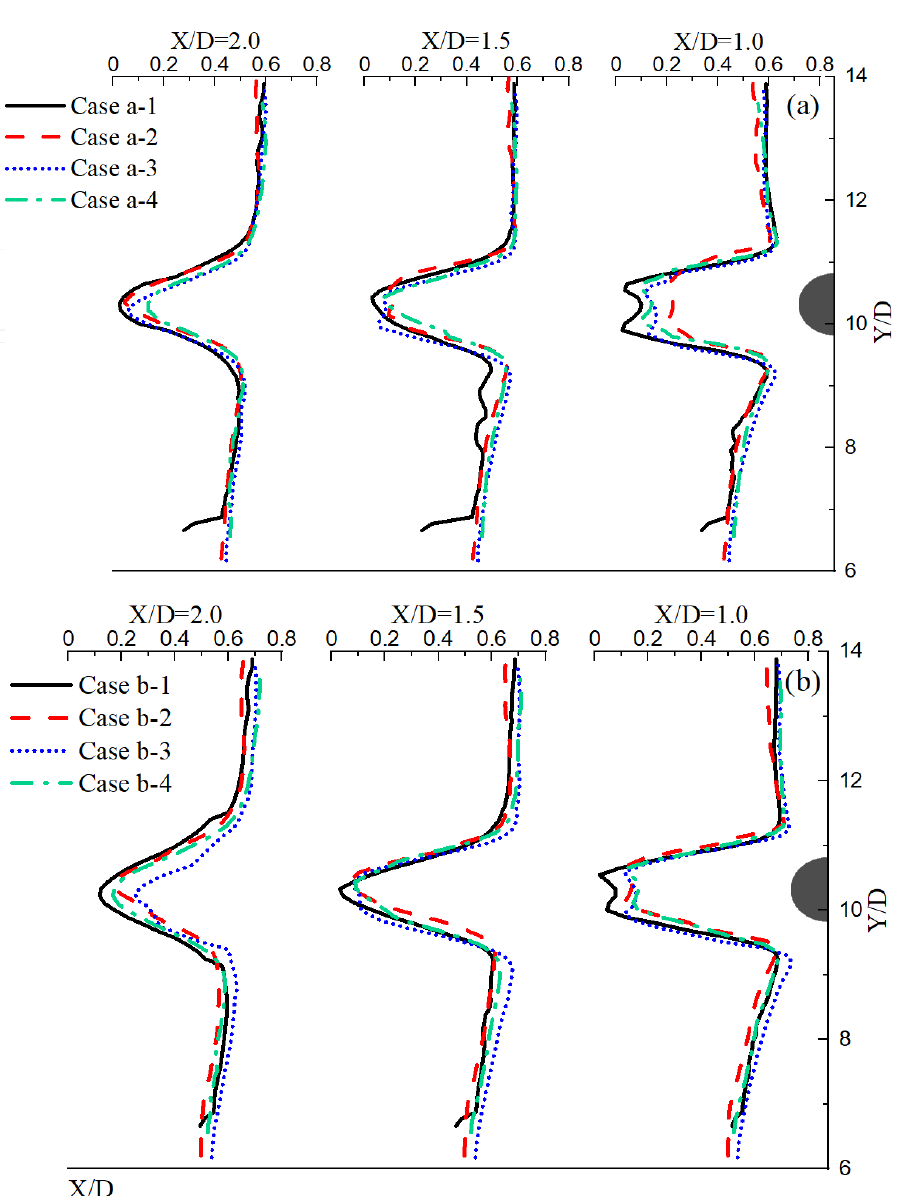
Figure 10. Time-averaged streamwise velocity distribution of the experiment at different positions with different dimpled numbers: ( a ) Re = 4.08 × 10 3 ; ( b ) Re = 8.14 × 10 3 .